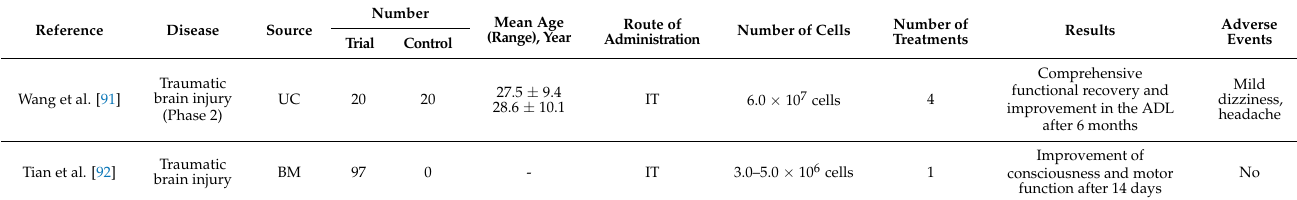
Table 7. Summary of recent clinical trials using MSCs for traumatic brain